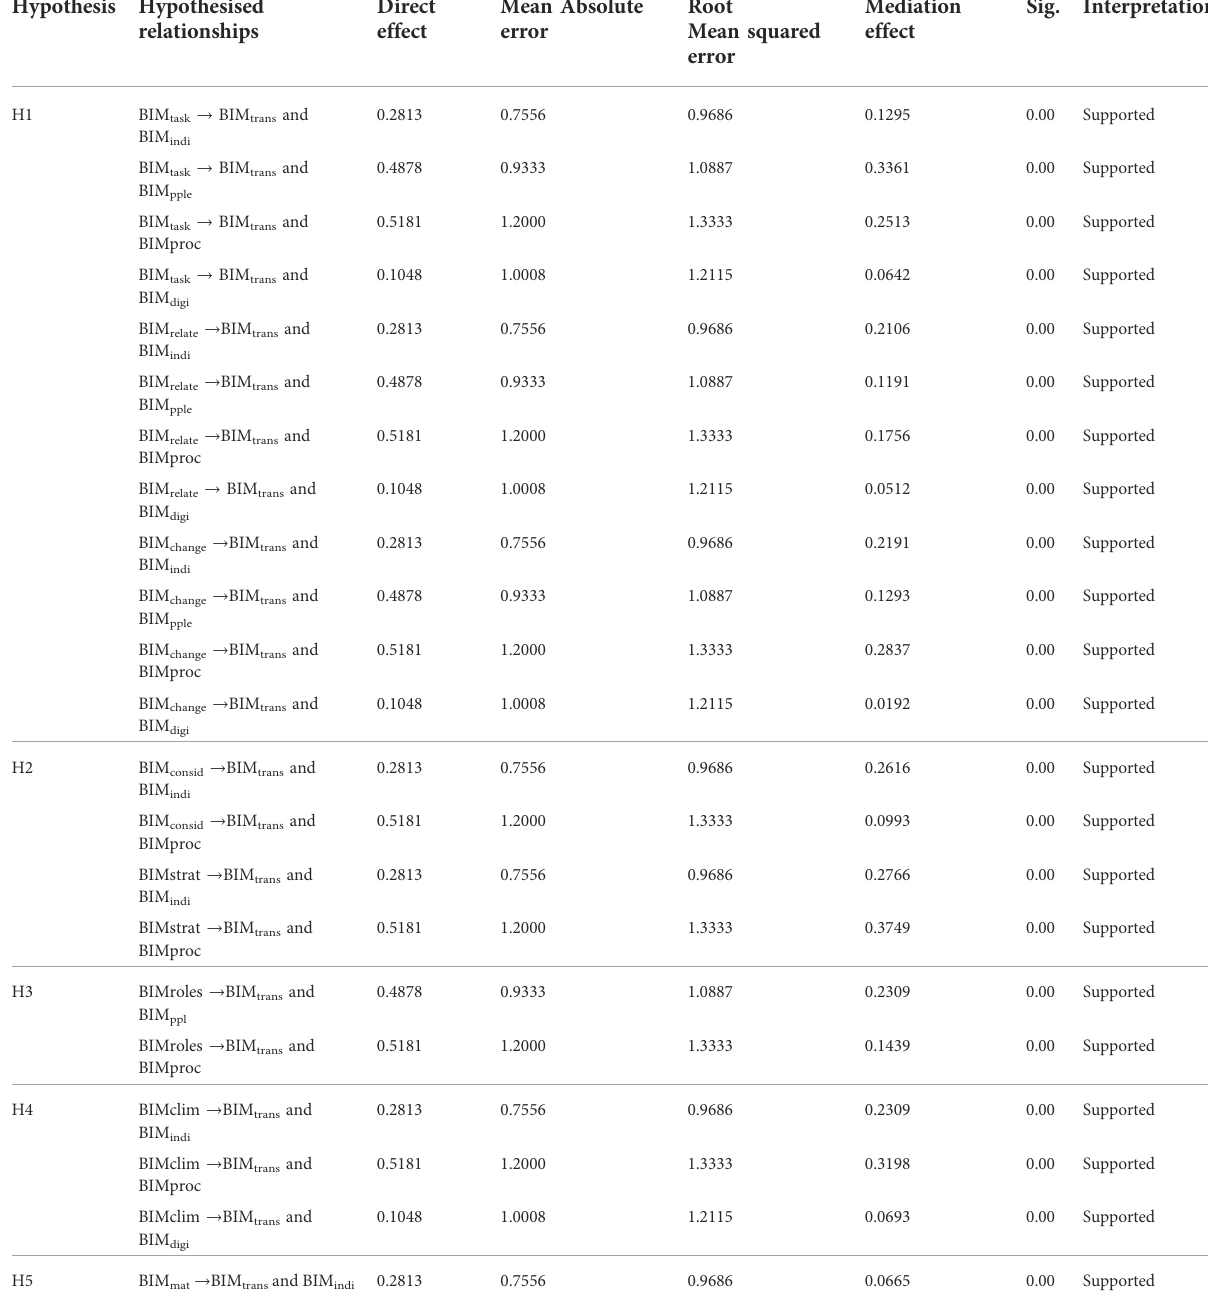
TABLE 2 Mediational effect of BIM leadership capacity on the causal relationship between BIM transformational leadership on organisational BIM transformation. Hypothesis Hypothesised